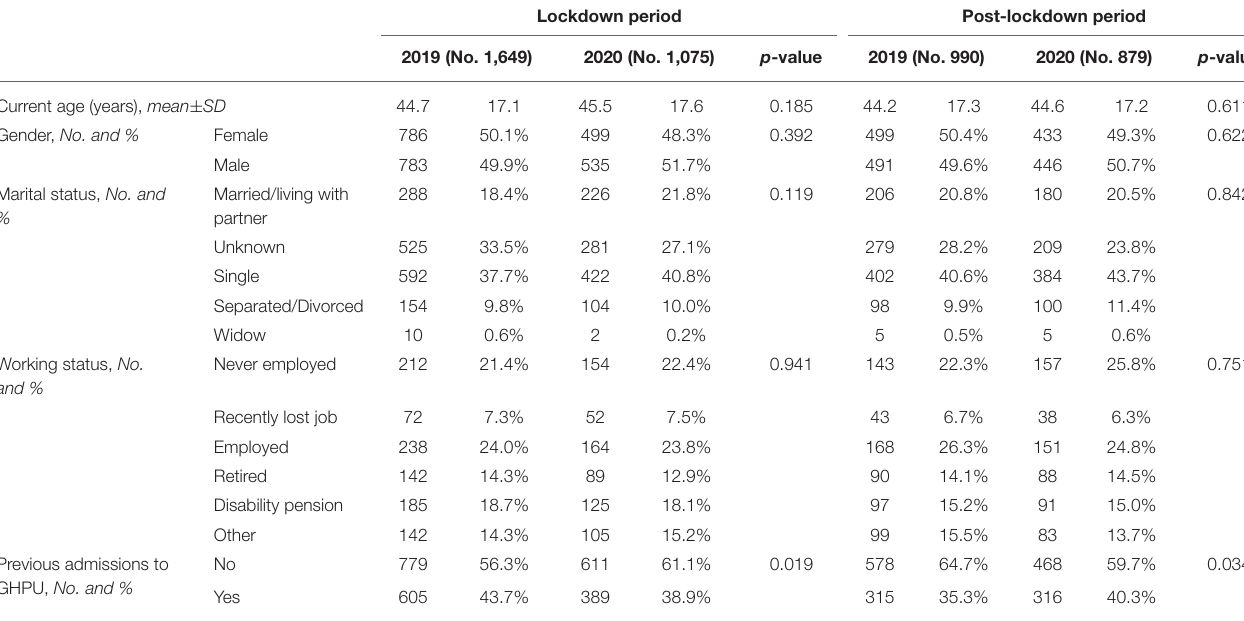
TABLE 1 | Patient characteristics by period and year.